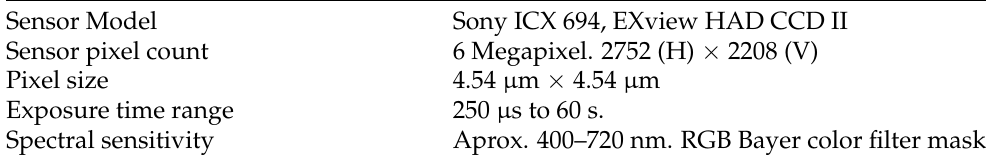
Table 4. Zeiss Axiocam basic